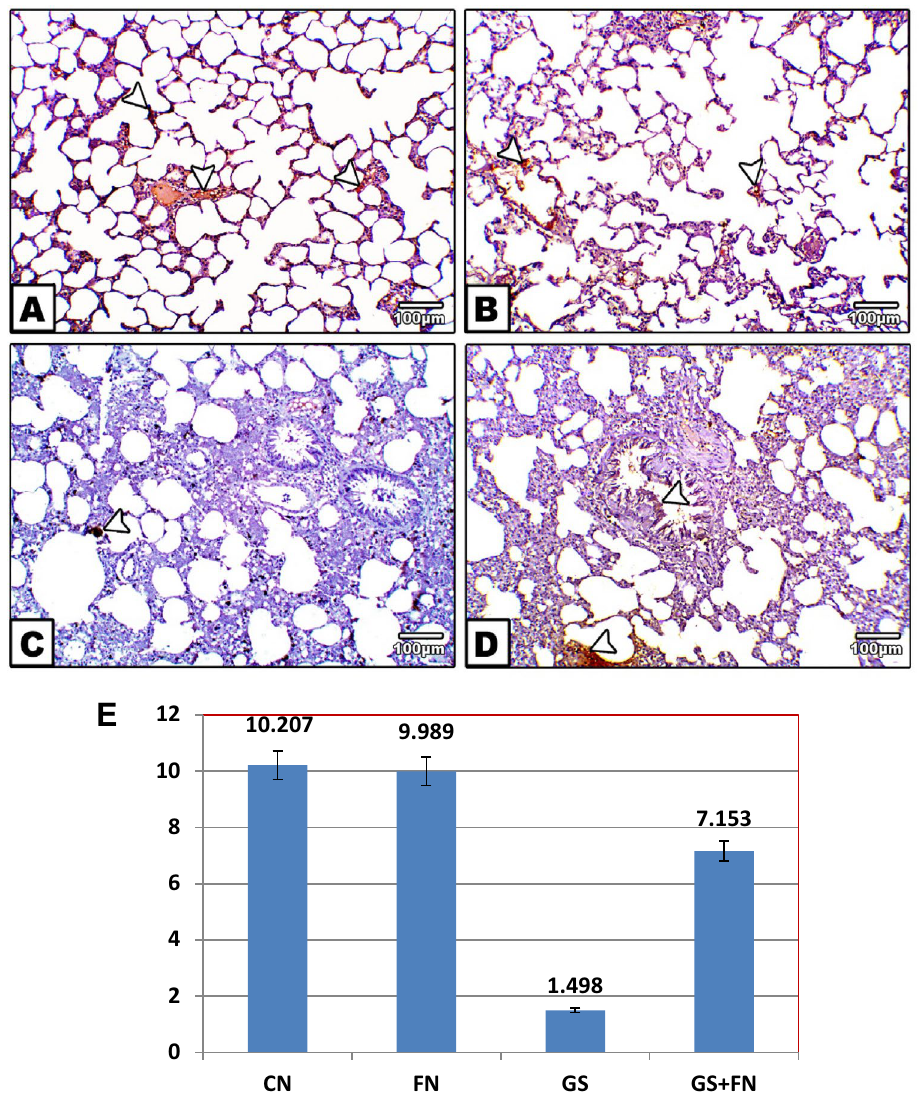
Figure 5. Photomicrographs of histological sections of lung immunohistochemically labeled with Bcl2 primary antibody. Unexposed control and fenugreek groups ( A , B ) showed alveolar tissue rich in the dark brown immunohistochemical reaction of Bcl2. The gasoline-exposed group ( C ) showed no immunohistochemical reaction of Bcl2 in inflamed lung cells. The gasoline-exposed group-administered fenugreek seeds ( D ) showed a mild increase in the immunohistochemical reaction of Bcl2 in lung cells. Arrowhead pointed to the increase in the immunohistochemical reaction of Bcl2. ( E ) Histogram showing the percentage of immunohistochemical reaction of Bcl2 in the lung of rat groups using image